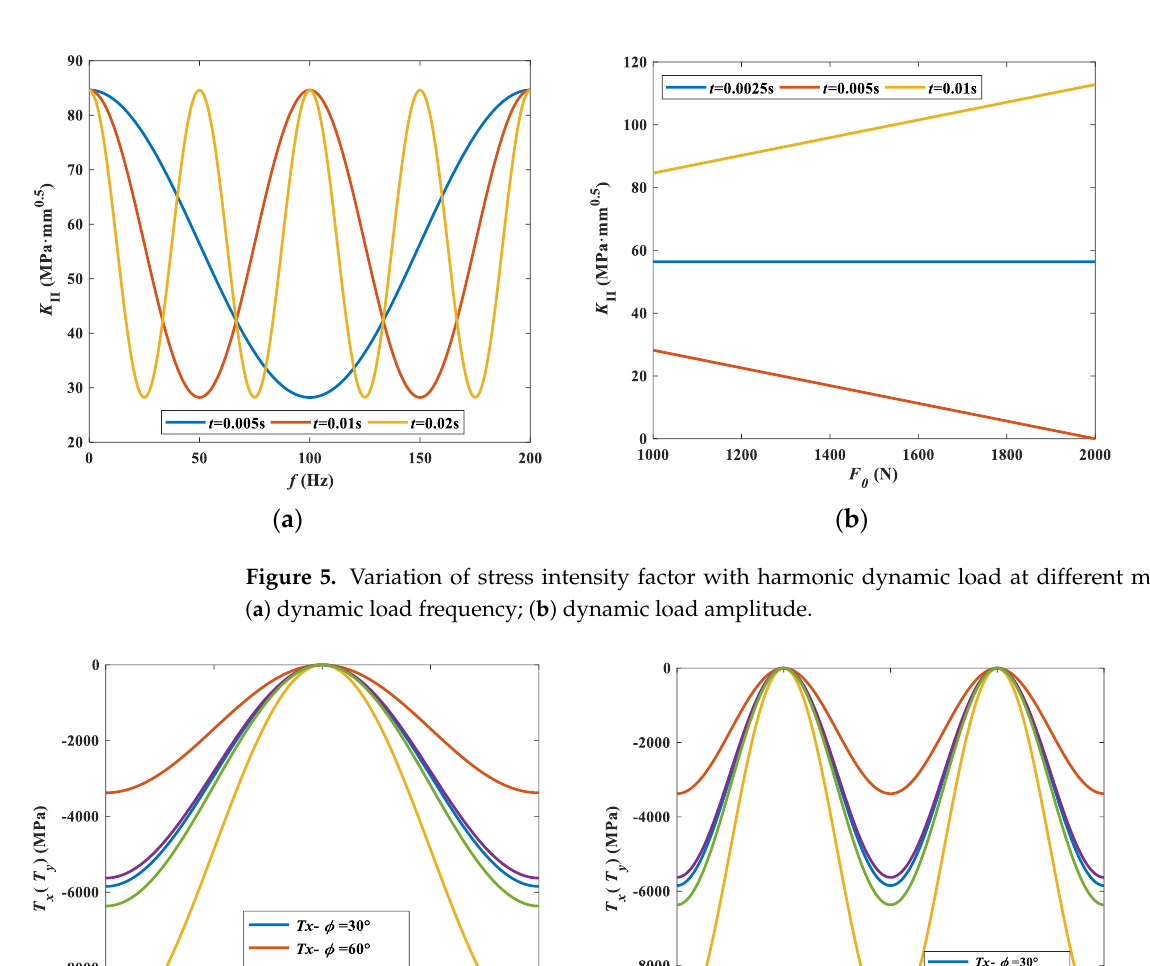
( b ) Figure 7. Variation law of T-stress with the amplitude of harmonic dynamic load at different rota- tion angles φ : ( a ) unloading stage at t = 0.005 s; ( b ) loading stage at t = 0.01 s. 4. Numerical Simulation 4.1. Modeling To further analyze the expansion characteristics of the crack within the strata under harmonic dynamic load, the extended finite element (XFEM) method is used to simulate the dynamic expansion of the crack in this paper. Since the XFEM does not need to deal